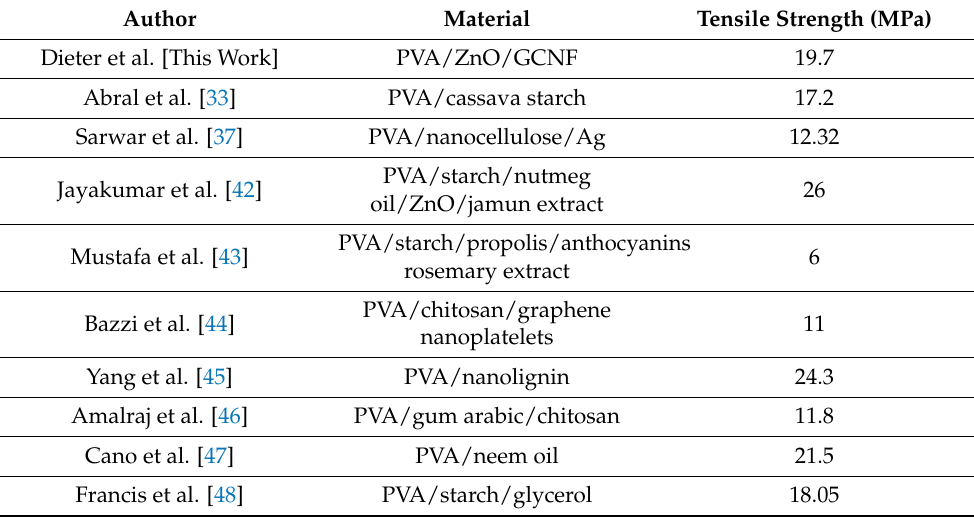
Table 3. The PVA composite film for food packaging applications reported in literature.